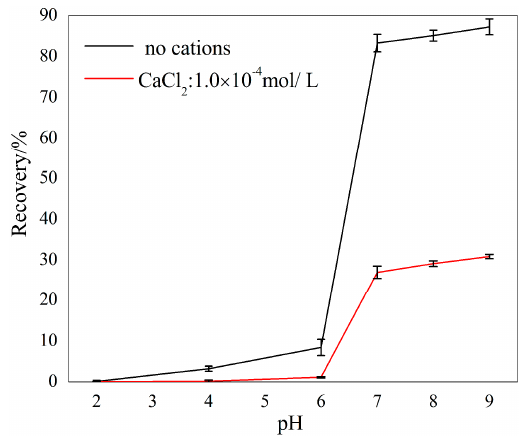
Figure 5. The flotation recovery of sillimanite as a function of pH with 4.50 × 10 − 4 M DAC.